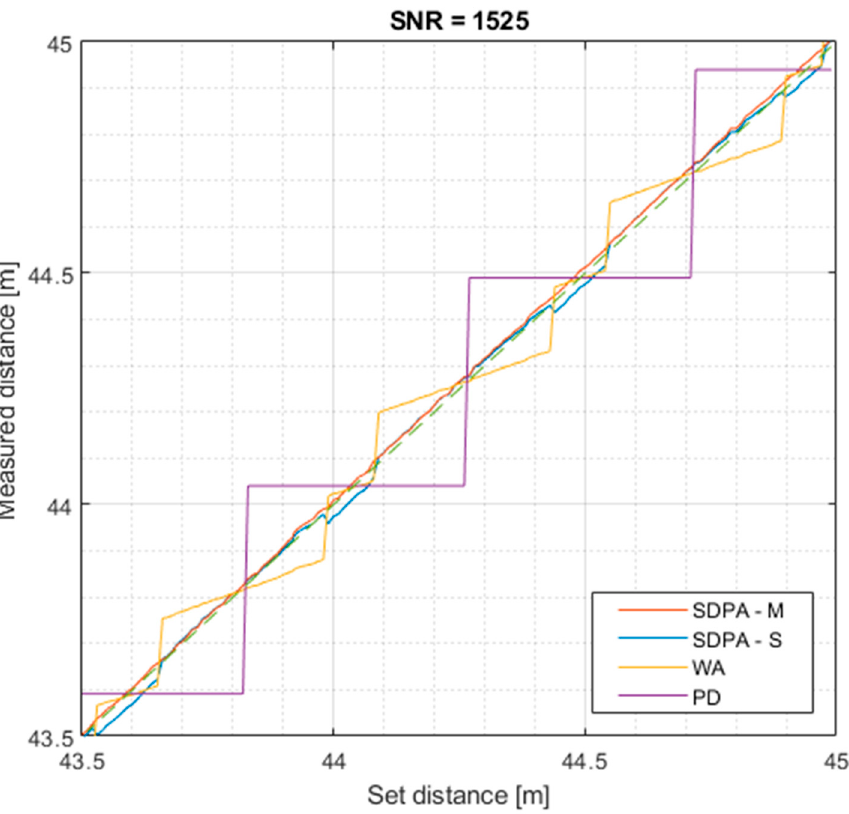
Figure 13. Distance measured with presented algorithms as a function of set distance for SNR = 1525. The reference line that shows ideal measuring results is marked with green color. The purple line marks results obtained with the peak detection (PD) algorithm. The yellow line shows results obtained with weighted average (WA) algorithm. The blue and red lines represent results obtained by algorithms of approximation with the second degree polyno- mial with, respectively, a simple and modified samples qualification method.